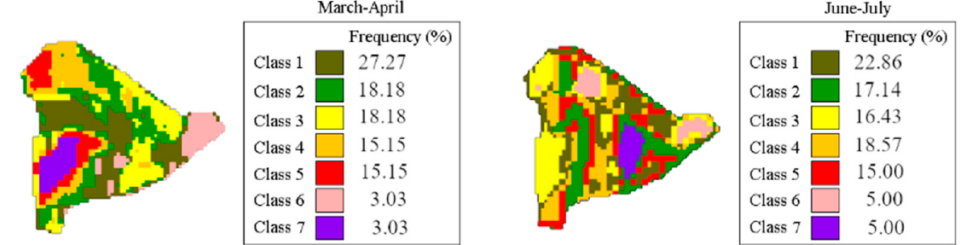
Figure 6. Unsupervised classification of piling images using K-means Cluster Analysis.